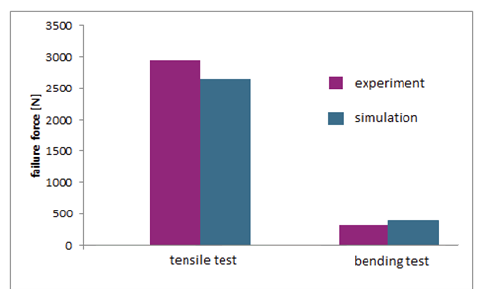
Figure 15. Illustration of the deviation between failure force in the experiment and in the